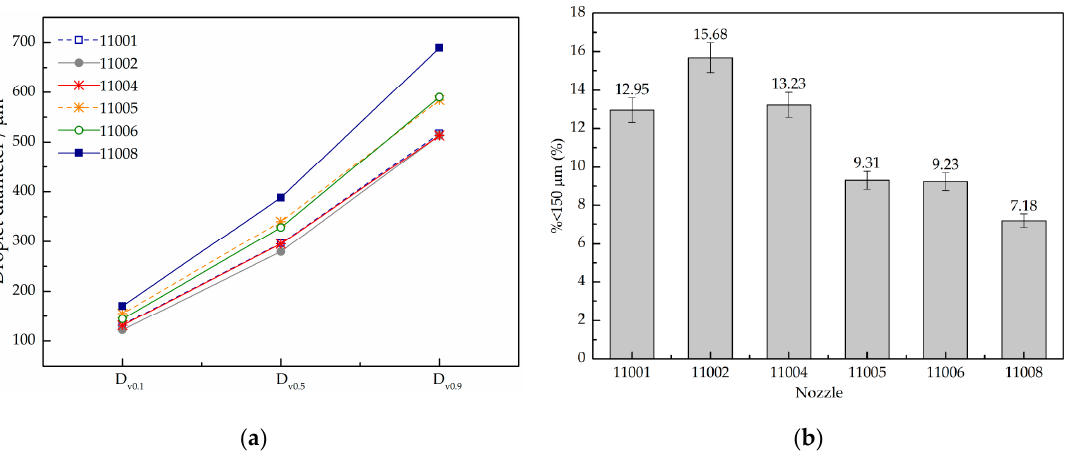
Figure 4. ( a ) Volume diameters below which smaller droplets constituted 10%, 50% and 90% of the total spray volume (D v0.1 , D v0.5 and D v0.9 ), and ( b ) proportion of spray volume contained in droplets with a diameter below 150 µm (% < 150 µm) of nozzles with different orifice sizes at 400 kPa and 3 m/s.